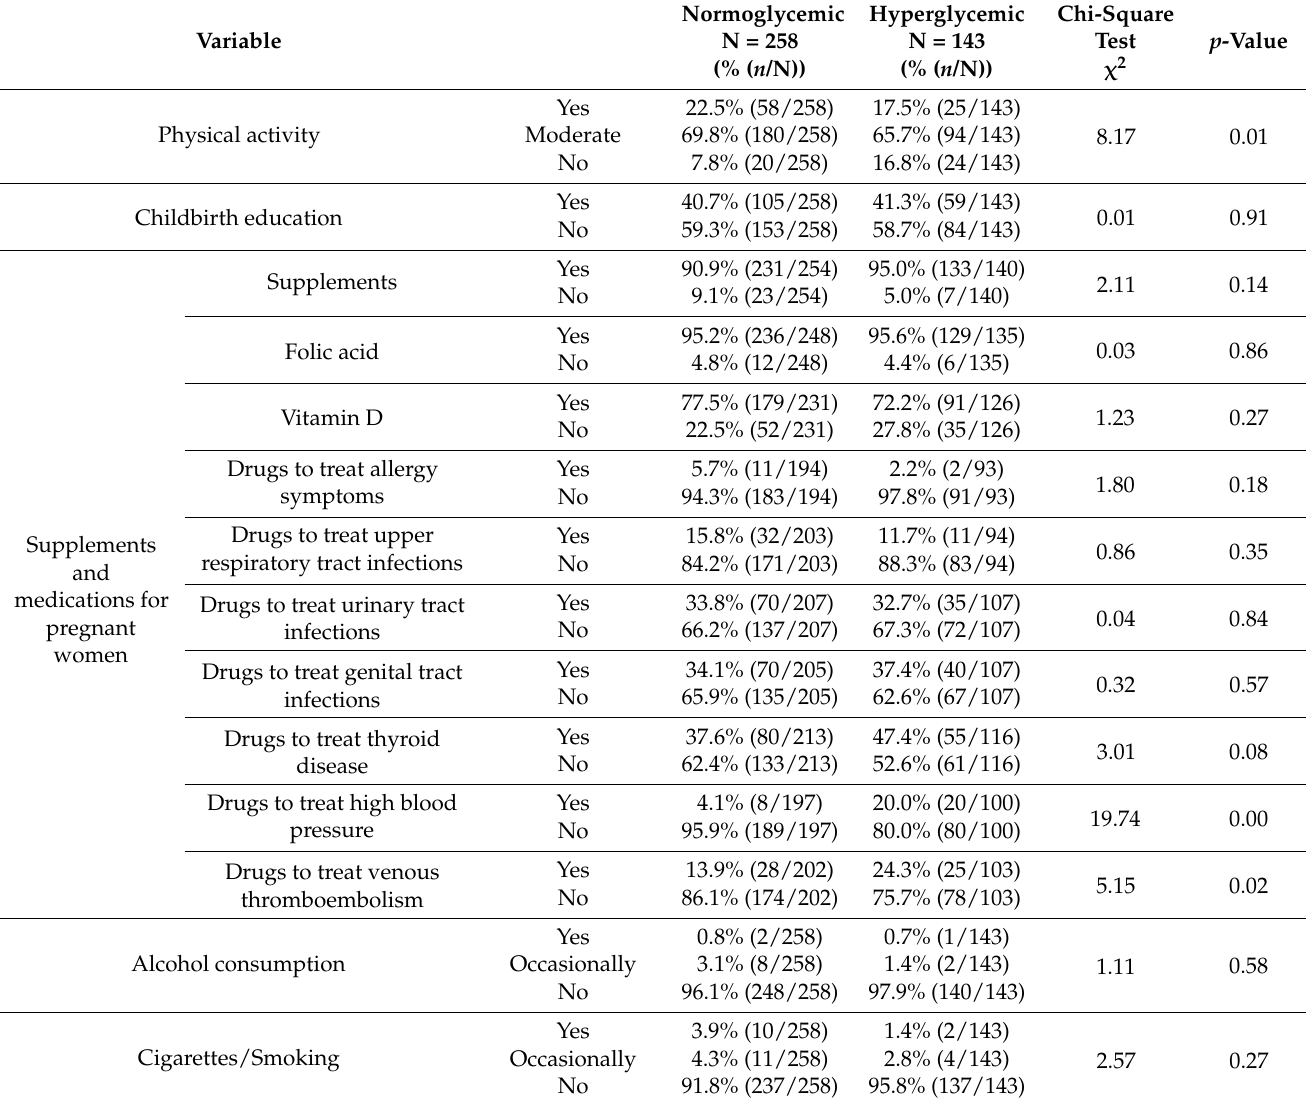
Table 4. Women’s management of pregnancy in relation to maternal glycemic